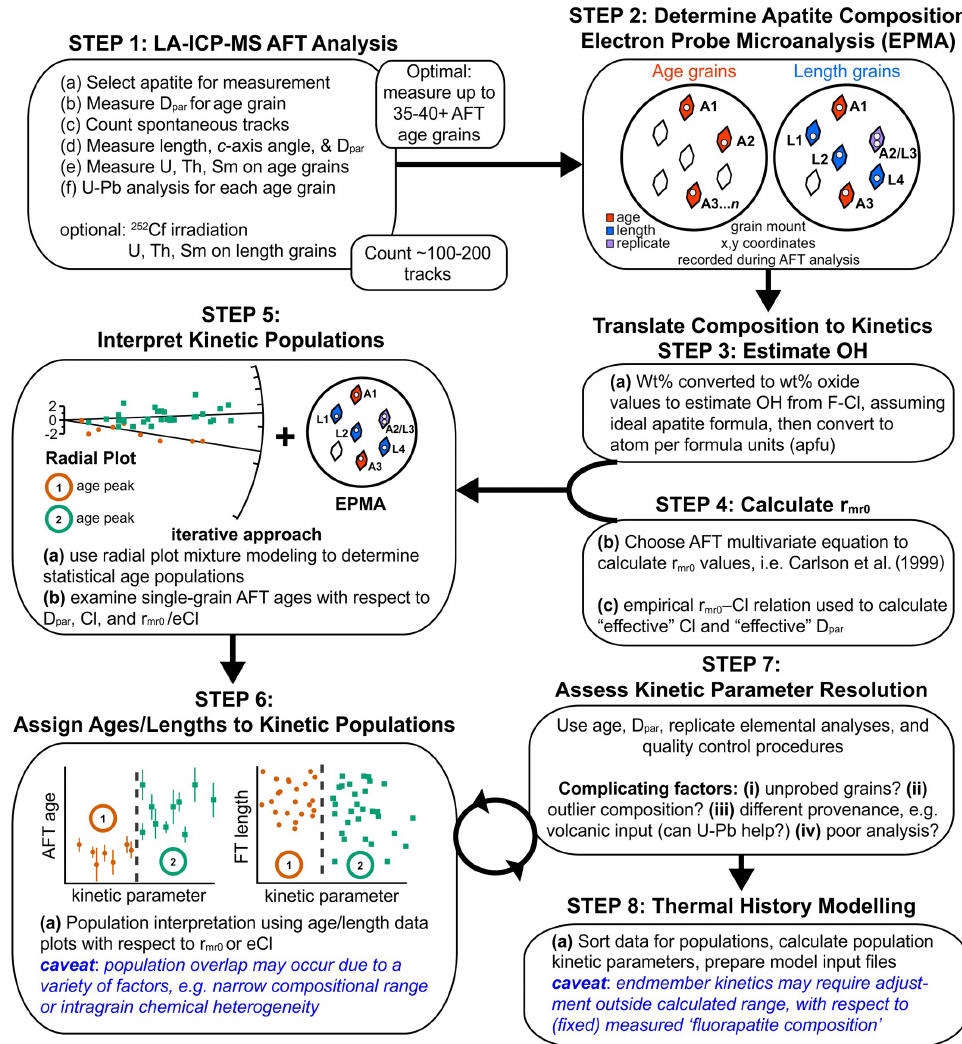
Figure 1. Flowchart outlining the key steps involved in the acquisition, interpretation, and modelling of multikinetic AFT